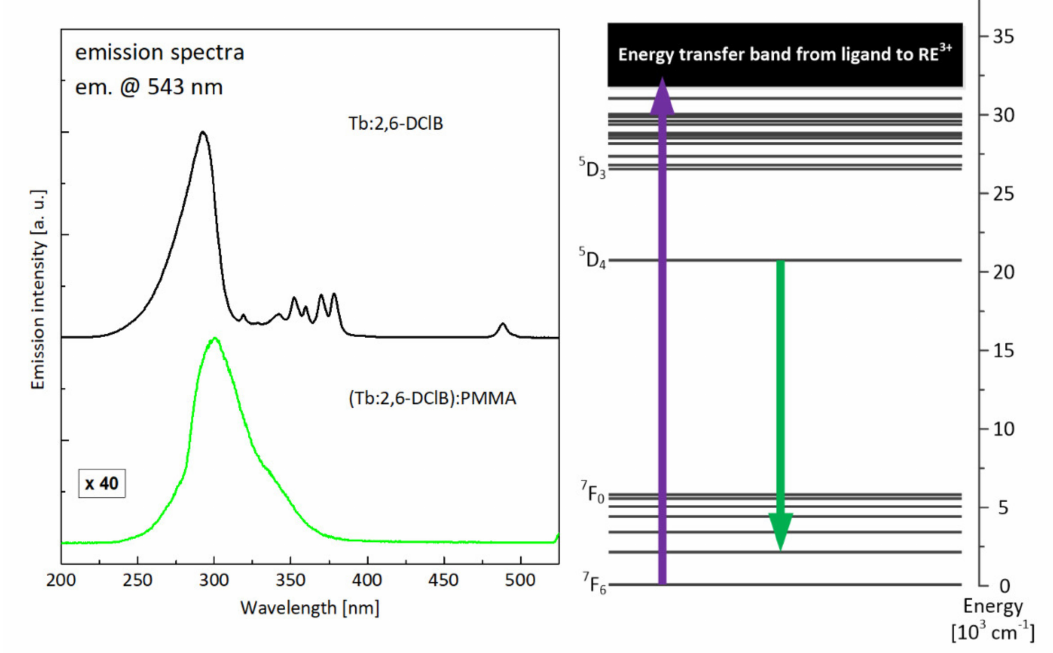
Figure 14. Comparison of excitation characteristics recorded for the Tb:2,6-DClB complex and the Tb:2,6-DClB/PMMA polymer composite, together with the attribution of the monitored luminescent transition against the energy-level scheme of